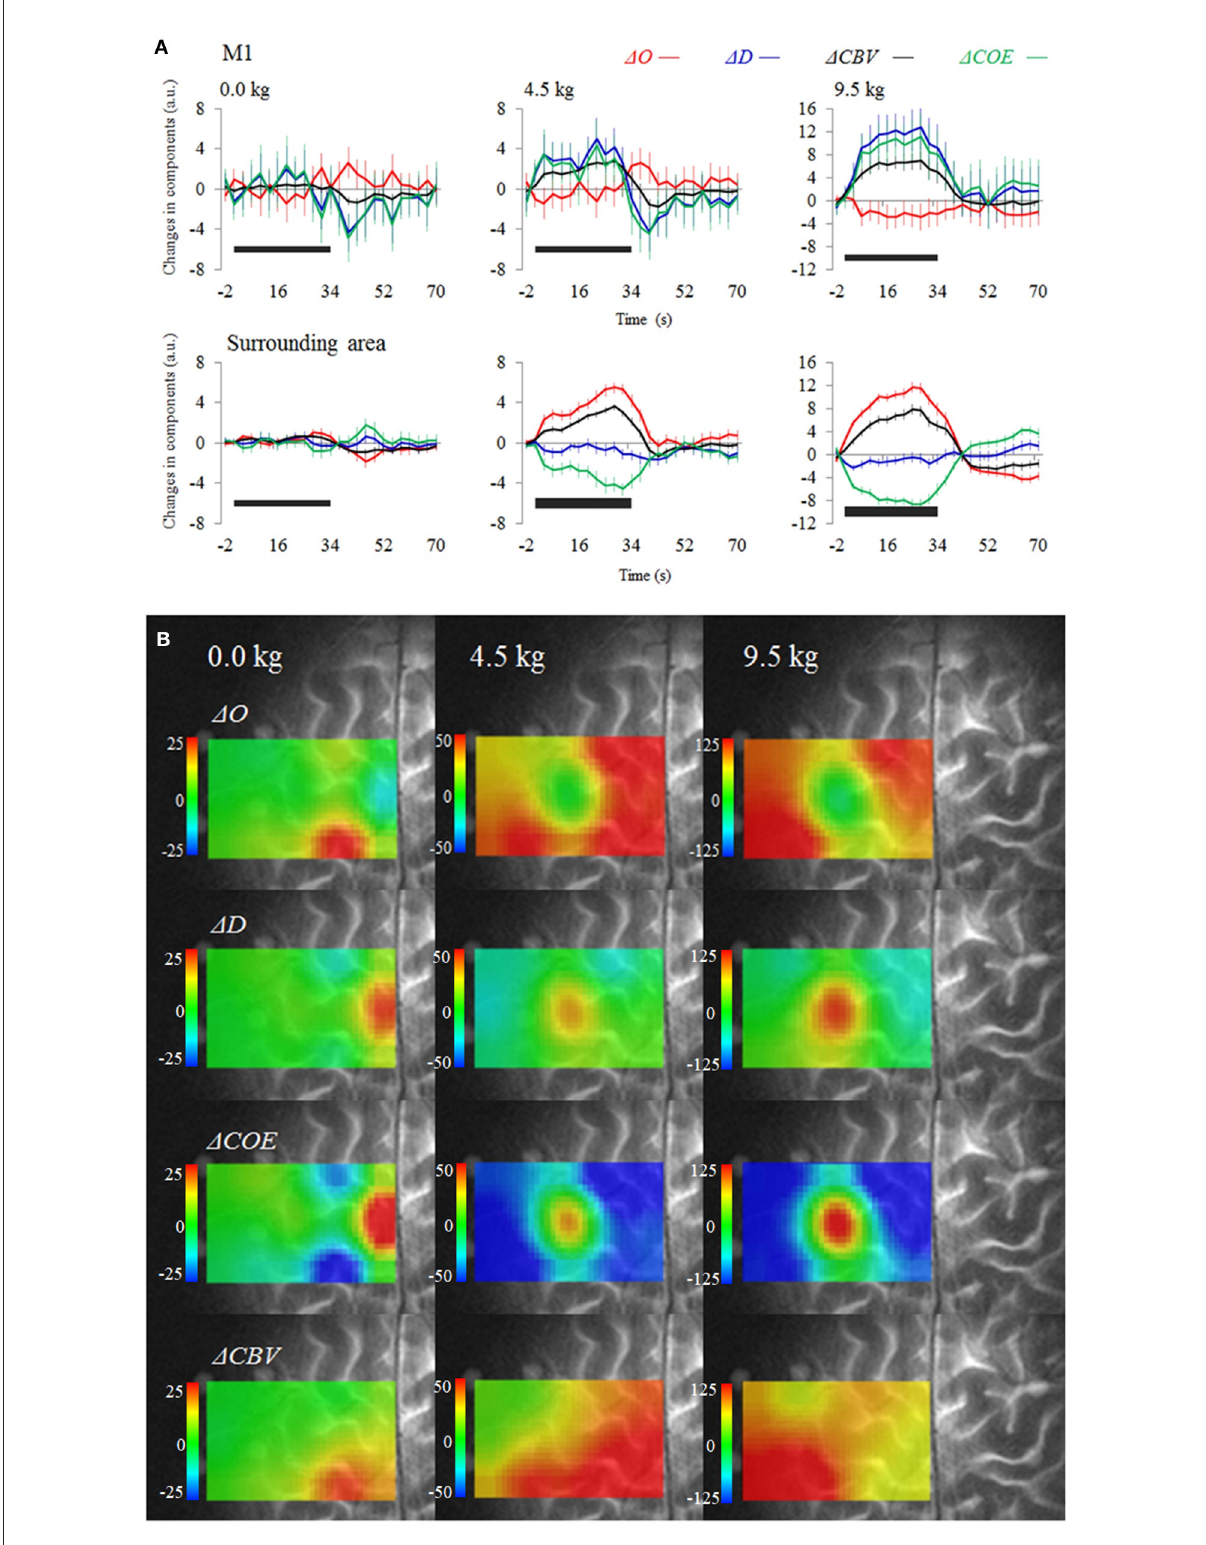
FIGURE3 (A) Average time courses and standard error for the four-vector components at the left M1 and surrounding sites (averaged). (B) Functional images show changes in the vector components during a task. The black bars on the figure represent the period of the dumbbell